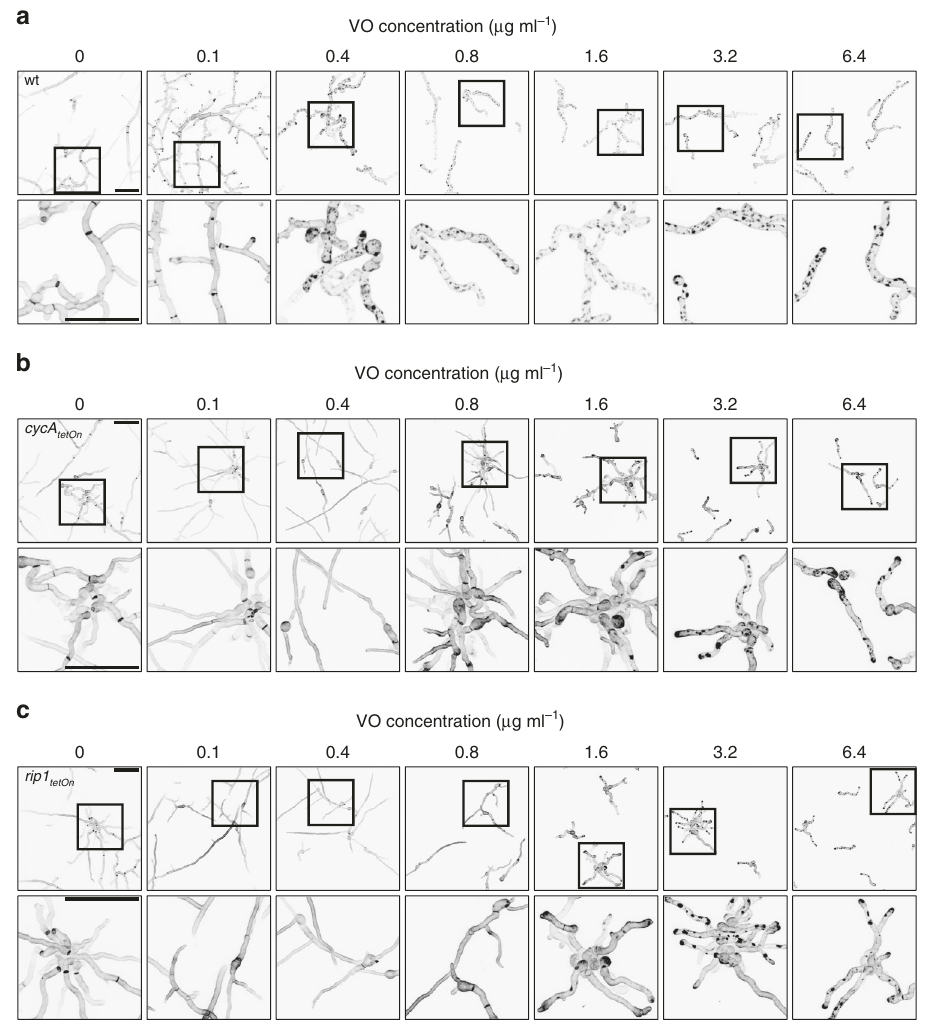
Fig. 6 Fungistatic azole concentrations do not trigger cell wall carbohydrate patch formation in mutants affected in the conventional mitochondrial electron transport chain. a – c Conidia of wild-type (wt; a ), cycA tetOn ( b ) and ript1 tetOn ( c ) were inoculated in Sabouraud medium and incubated at 37 °C. After 10 h incubation at 37 °C, the medium was supplemented with the indicated amount of voriconazole. After additional 10 h incubation, hyphae were stained with calco fl uor white, fi xed and analyzed with a confocal laser scanning microscope. Depicted are representative images of optical stacks of the calco fl uor white fl uorescence (chitin) that cover the hyphae in focus. The lower panels show magni fi cations of the framed sections in the upper panels. Bars represent 50 μ m and are applicable to all respective